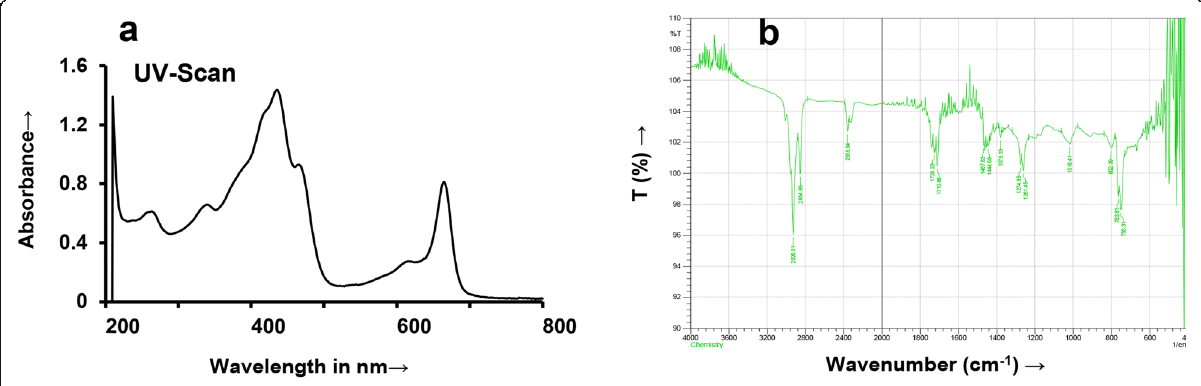
Fig. 1 UV-visible spectrum of methanol extract of C. vulgaris ( a ), FT-IR results from methanol extract of C. vulgaris ( b )